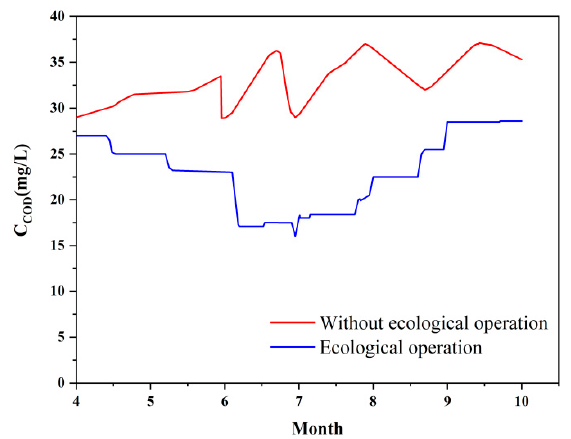
Figure 7. Simulated COD concentration before and after the ecological operation scheme.